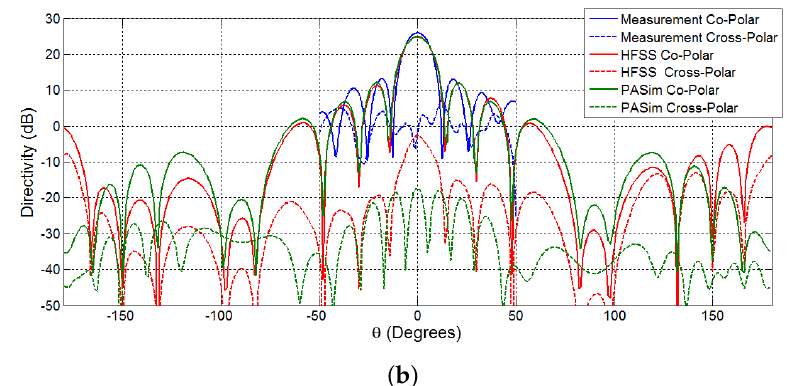
Figure 17. Principal plane cuts of eight-by-eight array simulations and measurements. Simulation patterns were generated by HFSS and PASim. Measured patterns were generated using near field measurements of each active element of the array. ( a ) Horizontal principal plane cut; ( b ) Vertical principal plane cut.